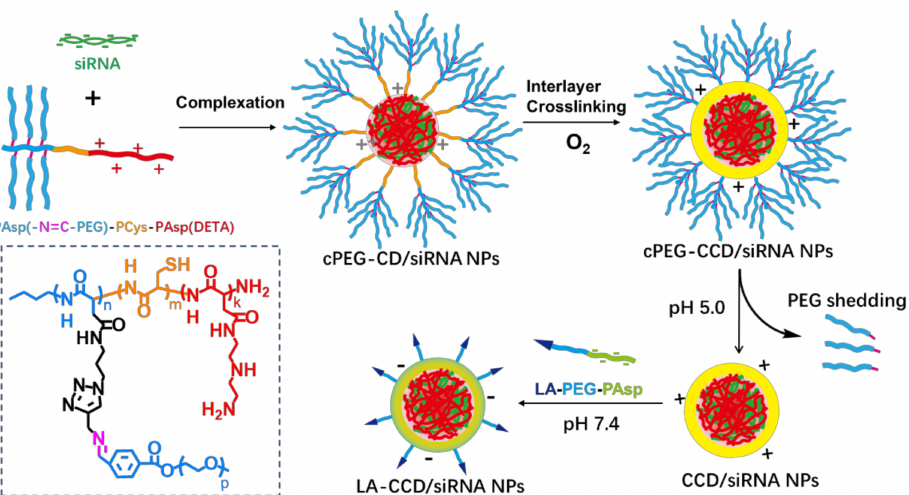
Figure 1. Schematic of the preparation of polyplex. The cationic copolymers cPEG-CD (i.e., PAsp(-N=C-PEG)-PCys-PAsp(DETA)) were used to complex with siRNA to form polyplexes cPEG- CD/siRNA nanoparticles (NPs). After O 2 blowing, thiol groups in the PCys interlayer crosslinked. Under pH 5.0 condition, PEG dropped from polyplexes because of the breakage of pH-sensitive imide bond. Finally, the negatively charged copolymers LA-PEG-PAsp were used to coat the CCD/siRNA NPs (crosslinked CD/siRNA NPs), introducing the targeting ligand lauric acid and neutralizing excessive positive charges.